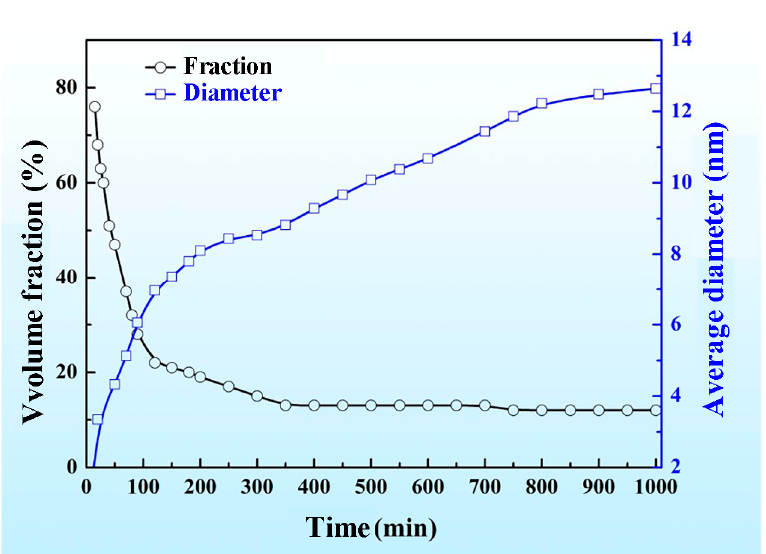
Figure 4. The change in the number and volume fraction of Zr-rich phases and Ti-rich phases in the Zr-40Nb-25Ti alloy aged at 900 K as a function of aging time.